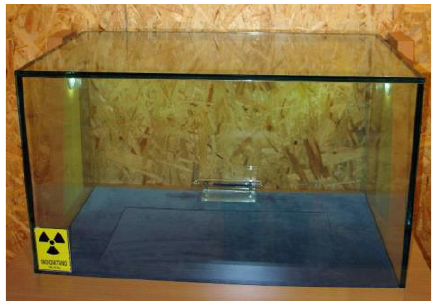
Fig. 4. Historical source: Therapeutic 226 Ra source.